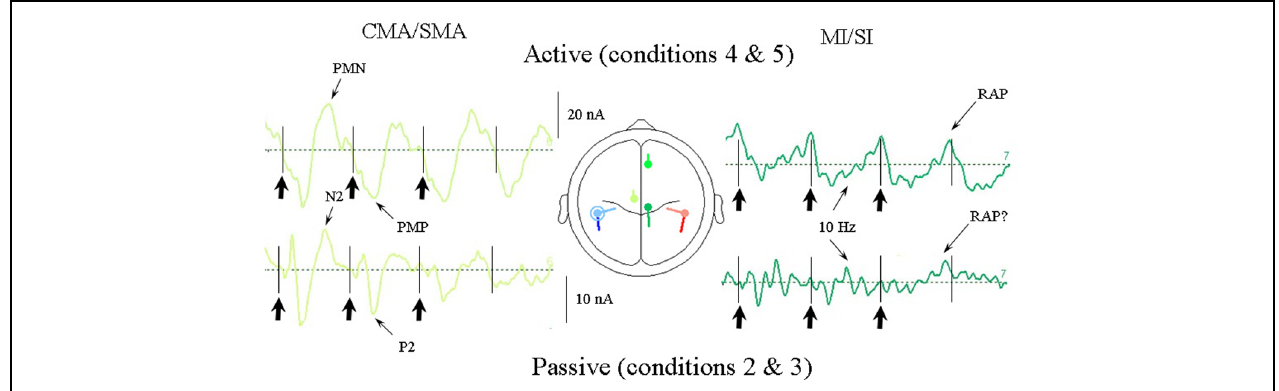
FIGURE 10 | Comparison of CMA/SMA and MI/SI source currents for the active vs. passive cases averaged over all the syncopation conditions. For the passive cases these are conditions 2, 3a, and 3b and for the active cases conditions 4, 5a, and 5b. The CMA/SMA activity is quite closely